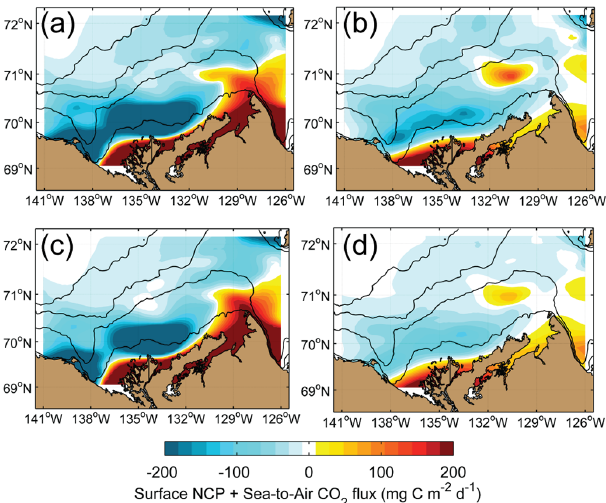
Figure A1. Results of a sensitivity analysis conducted on NCP and CO 2 flux estimates. As in Fig. 12, the positive values here mean that the potential for CO 2 sink due to a positive NCP was dampened by external forcings, while negative values mean that the potential for CO 2 source due to negative NCP (net heterotro- phy) was compensated by factors that lowered p CO 2 SW (e.g., cool- ing, dilution, inherent low p CO 2 owed to past photosynthesis). Maps were constructed using the range of possible NCP and CO 2 flux ( F CO 2 ) values as based on the error associated with each variable. (a) ( F CO 2 + 30%)+(NCP+75%); (b) ( F CO 2 + 30%)+(NCP − 75%); (c) ( F CO 2 − 30%)+(NCP+75%); and (d) ( F CO 2 − 30%)+(NCP − 75%). See Appendix A for further de-